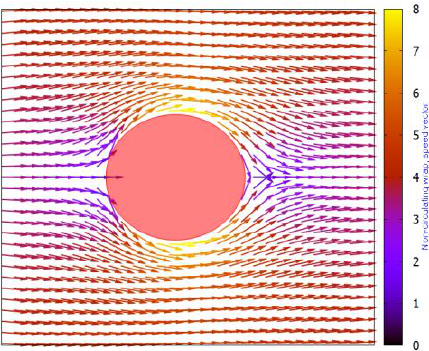
Fig. 3. Velocity field of a flat irrotational flow of an ideal fluid, when flowing around a round cylinder.